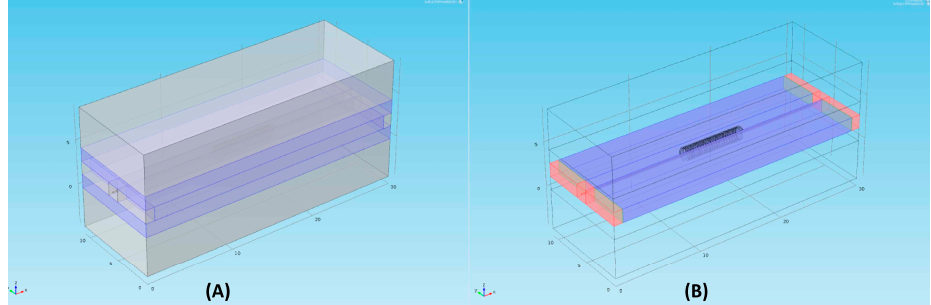
Figure 2. Model for simulating the electric field in the device installed with a coil. ( A ) Geometry of the whole device. The gray layers represent air layers while the purple domains refer to the PMMA boards; ( B ) Geometry of the middle layer of the device. A metallic coil is inserted inside a channel full of paraffin oil. The red domains are the two electrodes.